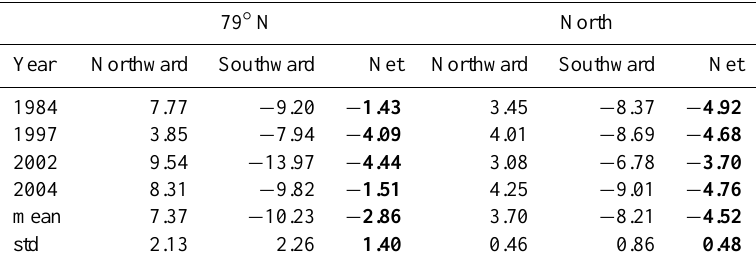
Table 1. Baroclinic volume transports (Sv) from zonal sections (no constraints applied) through the 79 ◦ N and the northern sections. Positive (negative) transports are northward (southward). 79 ◦ N North Year Northward Southward Net Northward Southward